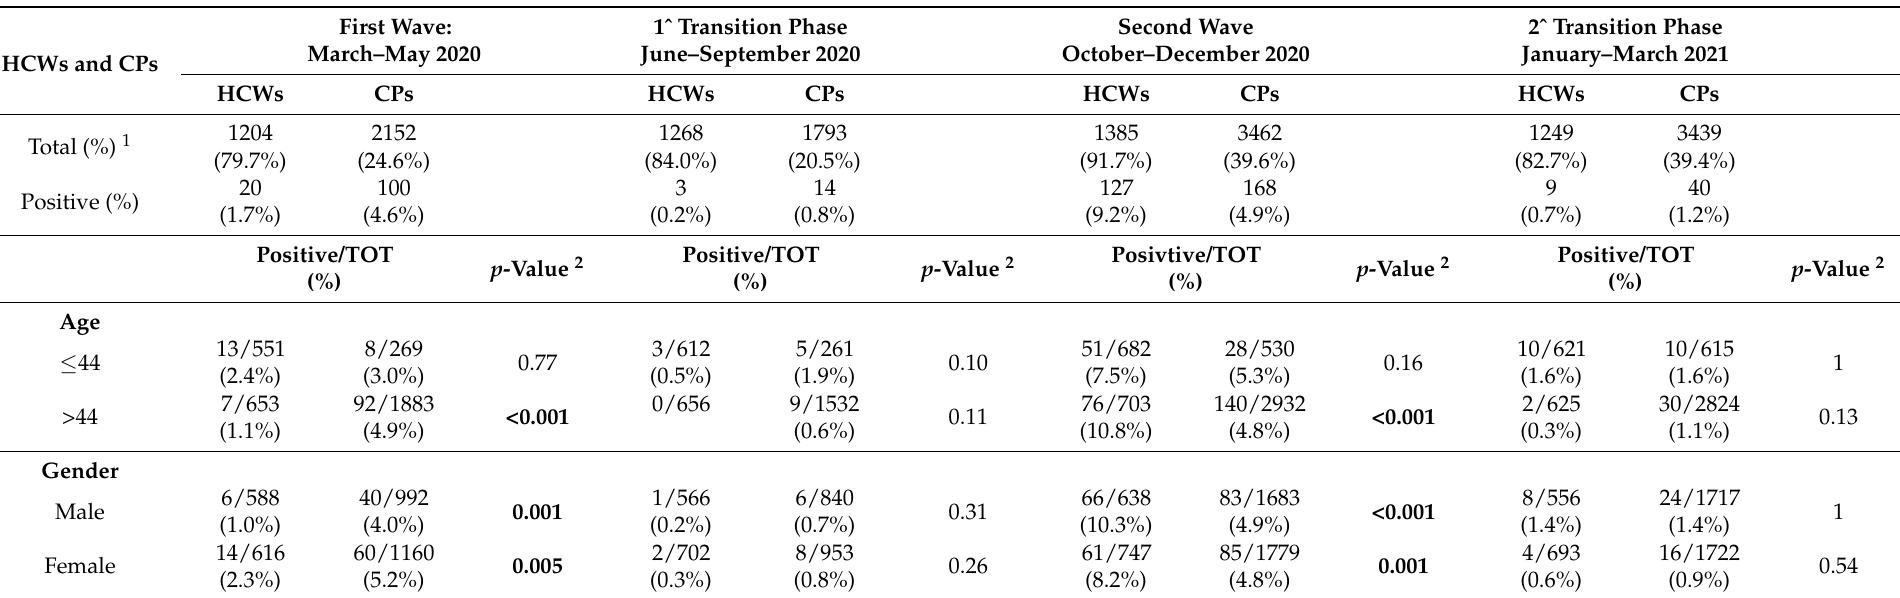
Table 1. SARS-CoV-2 incidence rate of Healthcare Workers (HCWs, Overall N = 5106 swabs for 1510 healthcare workers, multiple tests in the same wave are excluded) and Cancer Patients (CPs; Overall N = 10,846 accesses for 8733 patients, multiple accesses in same wave are excluded) from the first to the second wave of the